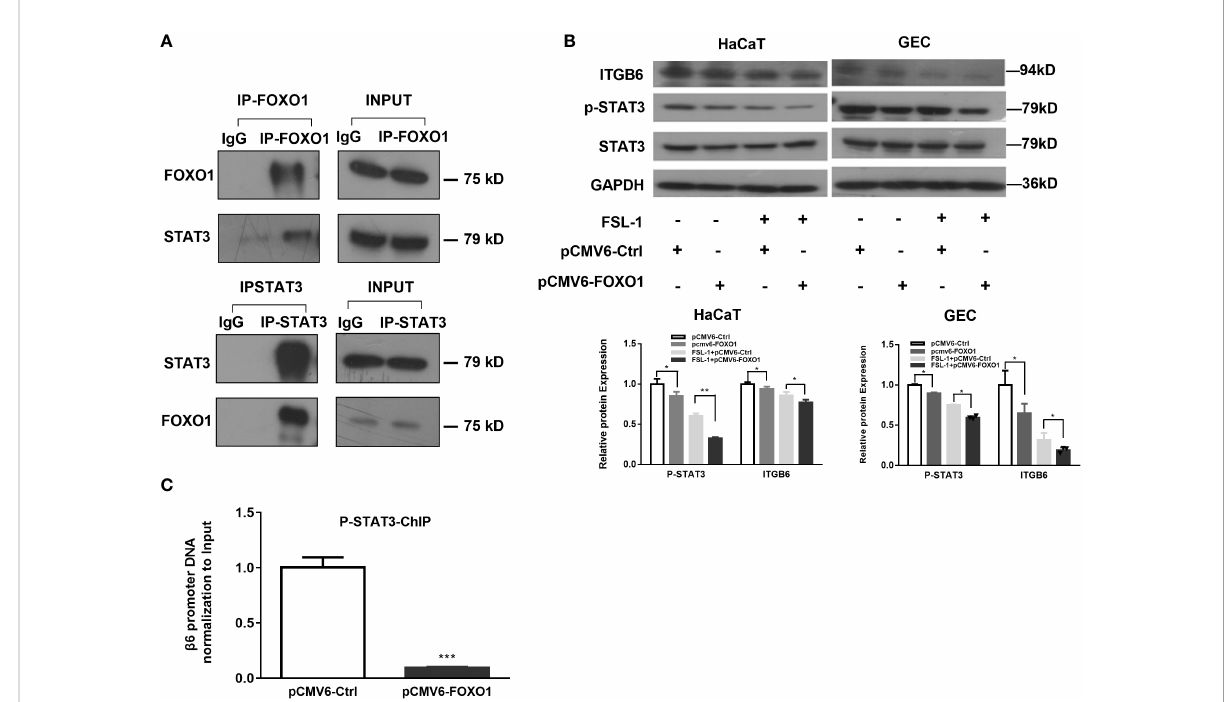
FIGURE 5 FOXO1-inhibited STAT3 activation is involved in FSL-1-mediated ITGB6 downregulation. (A) The interaction of STAT3 and FOXO1 was detected via co-immunoprecipitation in HaCaT cells. Cell lysate was incubated with FOXO1, STAT3 antibodies or control IgG. The corresponding interacting protein was then detected by western blotting using antibody against STAT3, FOXO1, or IgG. Cell lysate (5%) was used as input positive control. (B) Overexpression of FOXO1 inhibited STAT3 activation and ITGB6 expression. HaCaT cells were transfected with pCMV6-Ctrl or pCMV6-FOXO1 plasmids for 24 h before treatment with or without FSL-1 (100 ng/mL) for 2 h. The protein expression of FOXO1, STAT3, p- STAT3, and ITGB6 was analyzed using western blotting. (C) FOXO1 overexpression inhibited phosphorated STAT3 binding to the ITGB6 promoter. HaCaT cells were transfected with pCMV6-Ctrl or pCMV6-FOXO1 plasmids for 24 h. The binding of phosphorated STAT3 to the ITGB6 promoter was detected by ChIP assay. The associated ITGB6 promoter DNA was ampli fi ed by qPCR using primers covering the potential STAT3-binding sites from − 289/ − 150 of ITGB6 promoter. The input was 5% of the total cell lysate. Data are shown as mean ± SEM of triplicates and compared, V6-Ctrl group. *P < 0.05, **P < 0.01, ***P <